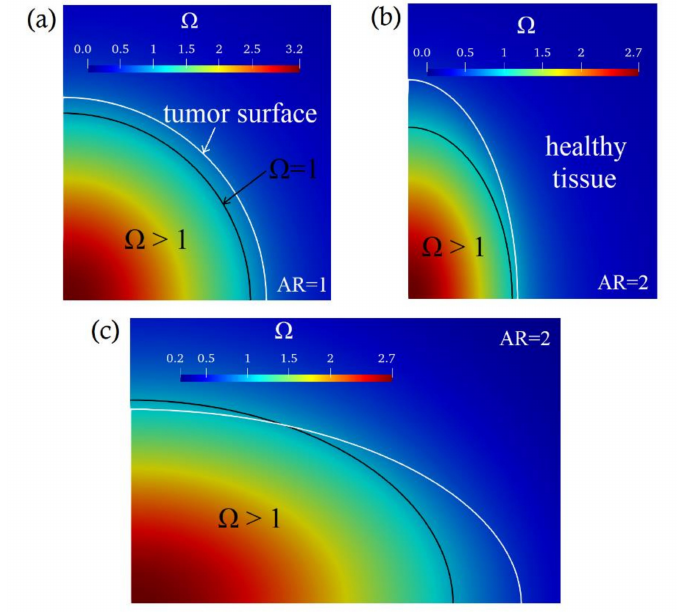
Figure 10. Thermal damage in three tumor shapes and for a healthy tissue region close to the tumor after 22 min of treatment: ( a ) AR = 1, ( b ) prolate with AR = 2 and ( c ) oblate with AR =